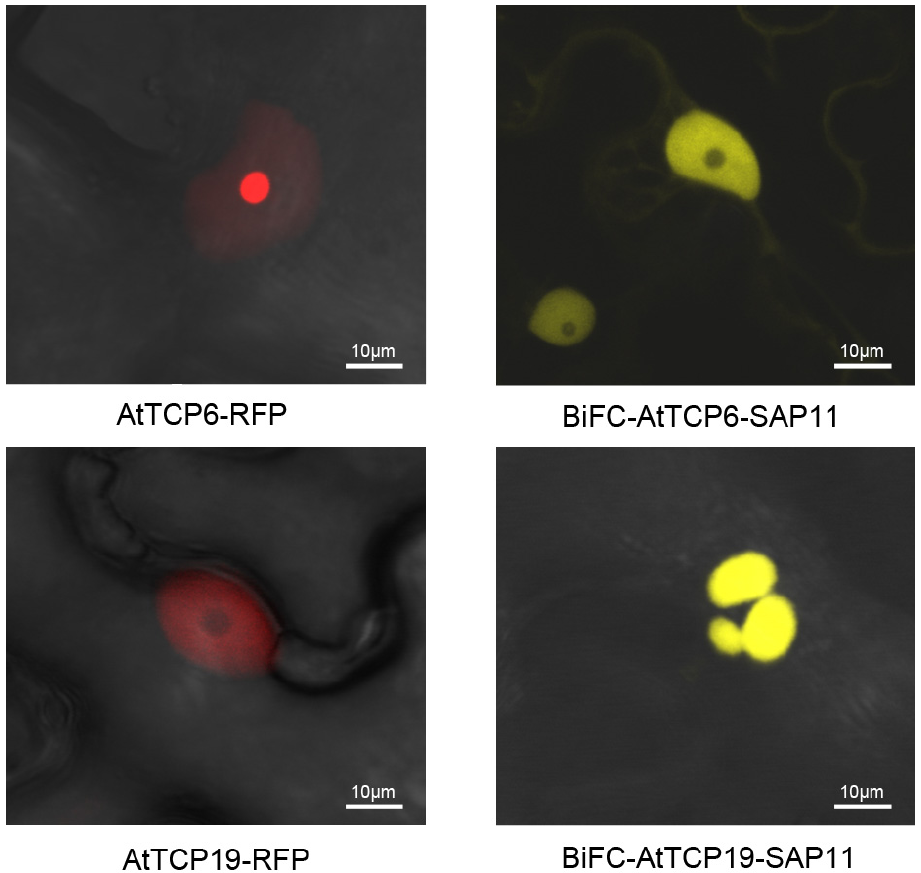
Figure 5. In vivo protein interaction of SAP11 PM19 and AtTCP6 and 19. SAP11 PM19 and AtTCP6 or AtTCP19 were fused with each half of YFP in BiFC system. The proteins were transiently expressed via agroinfiltration in N. benthamiana . The protein interactions were visualized under a confocal microscope using RFP and GFP filters. The localizations of SAP11 PM19 and AtTCP6 or AtTCP19 complexes (BiFC-AtTCP6/19-SAP11, right panel) are compared with the localization of AtTCP6 or AtTCP19 fused RFP (AtTCP6/19-RFP), respectively (left panel).